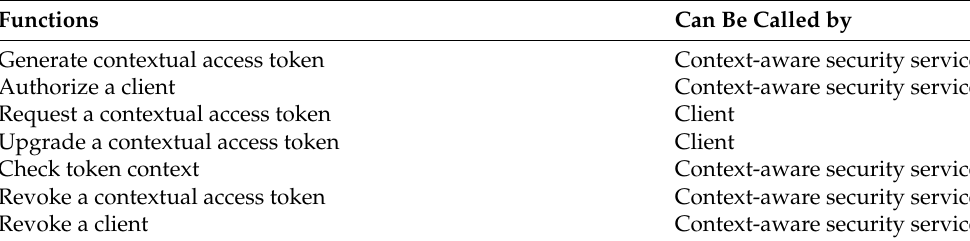
Table 2. User smart contract